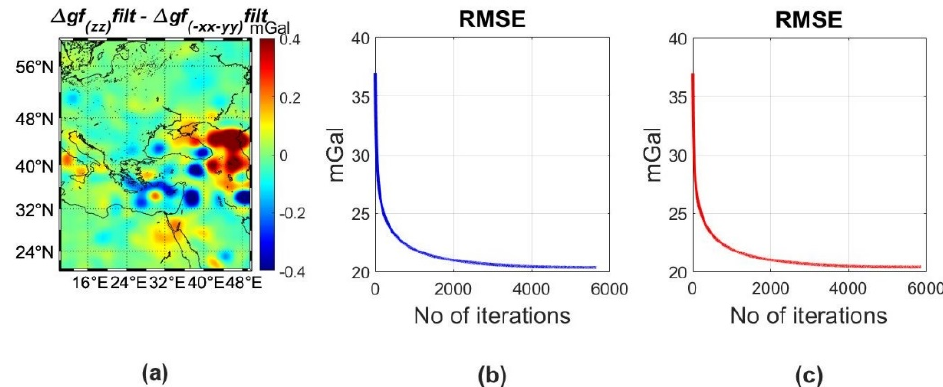
Figure 8. ( a ) The filtered synthesized 𝑇 (cid:2879)(cid:3051)(cid:3051)(cid:2879)(cid:3052)(cid:3052)(cid:3014)(cid:3016) 𝑓𝑖𝑙𝑡 at MO = 230 km, ( b ) the DC free-air gravity anomalies on earth’s surface (𝛥𝑔𝑓 𝑓𝑖𝑙𝑡) , ( c ) their residuals (𝛥𝑔𝑓 (cid:3045)(cid:3032)(cid:3046) 𝑓𝑖𝑙𝑡) with the ground data based on TIM_R6 d/o 300.